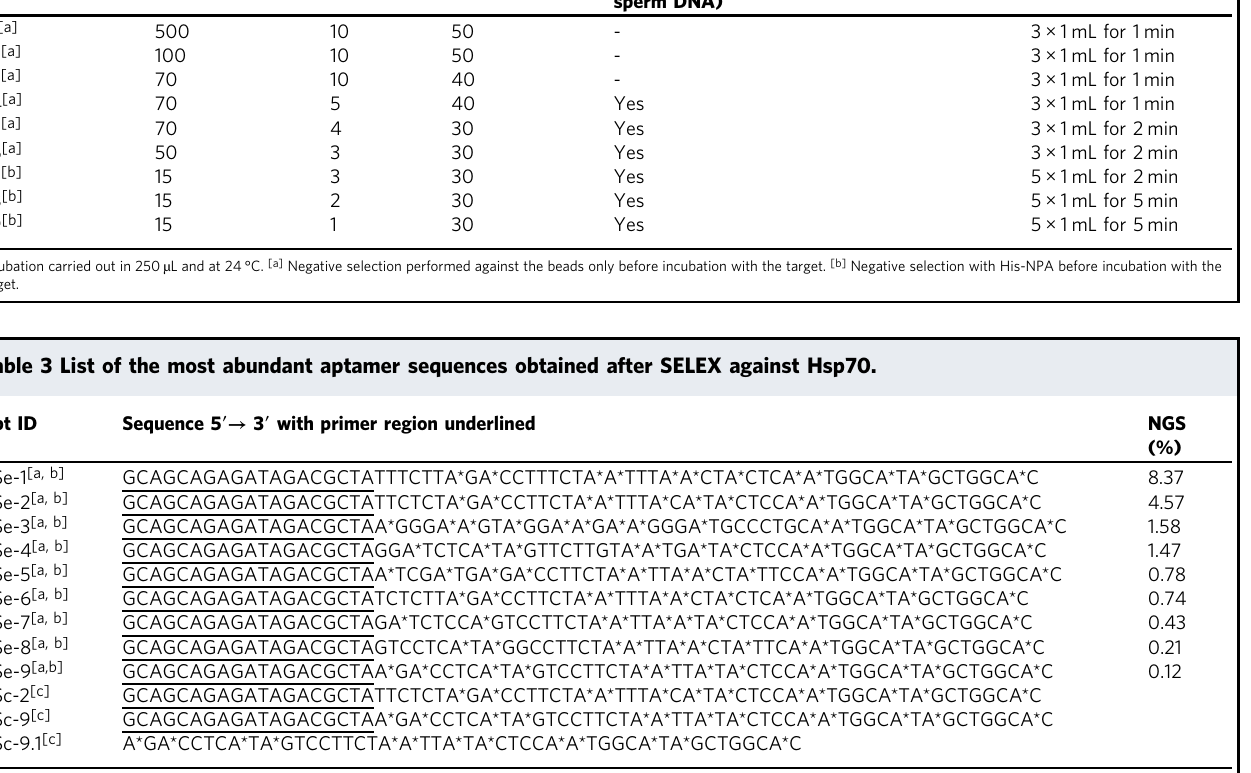
Table 2 Selection conditions used in each round of the modi fi ed SELEX procedure against Hsp70. SELEX round